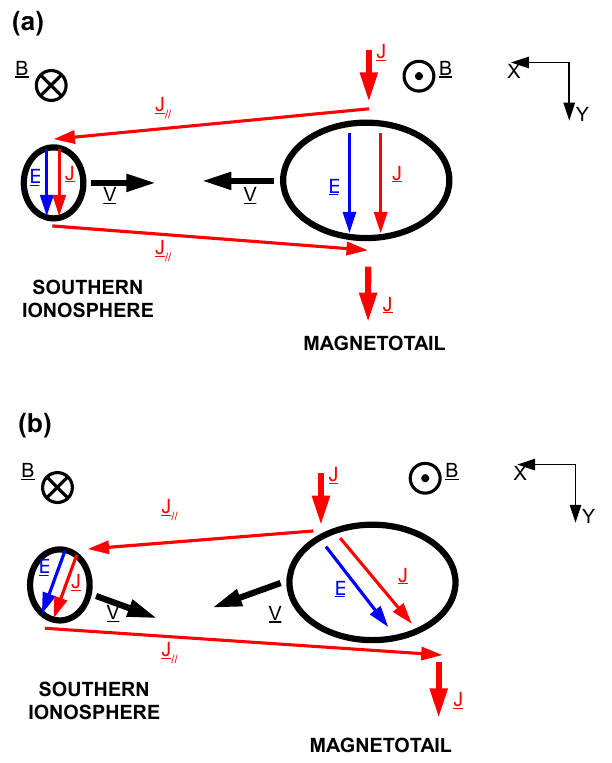
Fig. 17. An illustration, looking down on the north pole, of the ex- pected plasma bubble current systems during (A) the simplest case and (B) when there is a positive B Y present. Currents are drawn in red, electric fields in blue and velocities in black. The black ellipses represent the boundaries of the depleted flux tube in the magnetotail just south of the neutral sheet (right) and the southern ionosphere